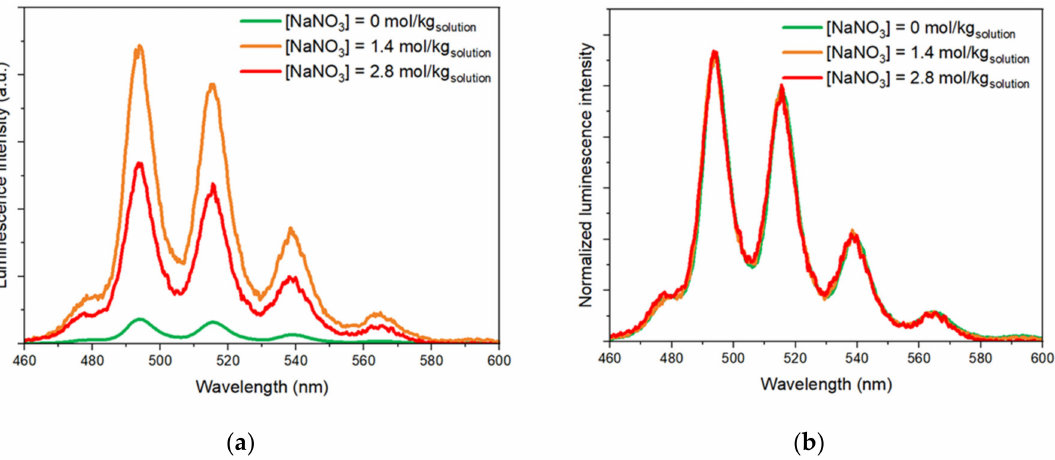
Figure 4. Luminescence spectra of U(VI) in 0.8 mol/kg w H 3 PO 4 and as a function of NaNO 3 content: ( a ) luminescence spectra normalized considering the U(VI) concentration; ( b ) U(VI) luminescence spectra normalized to the area of the